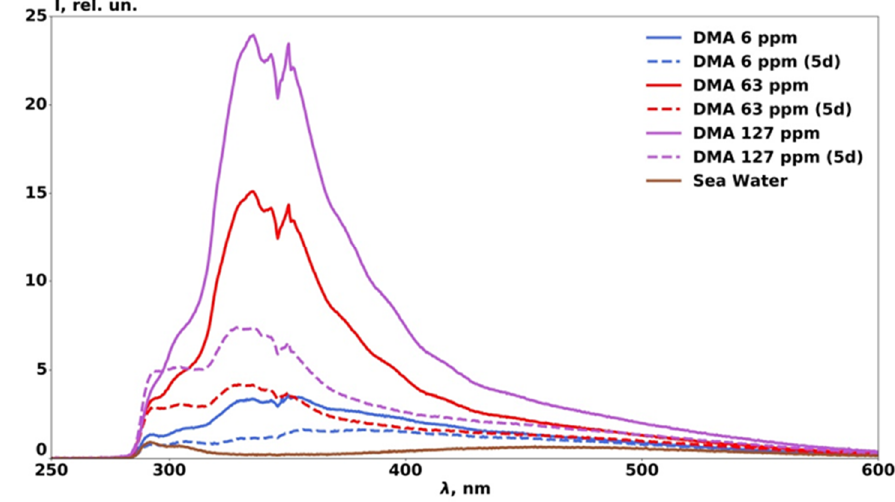
Figure 12. Dynamics of the DMA spectra for 5 days. Di ff erent colors correspond to the di ff erent concentrations of solutions in Figure 12. The spectral distributions of solutions after five days of dissolution are marked by the dashed lines. The intensity of the signal was reduced more than twice for all the measured concentrations after five days. Almost the same change of the fluorescence intensity was being observed for the other types of fuels. Nonetheless, some change in the spectral distribution form can be noticed and used as distinctive features for the age of solution